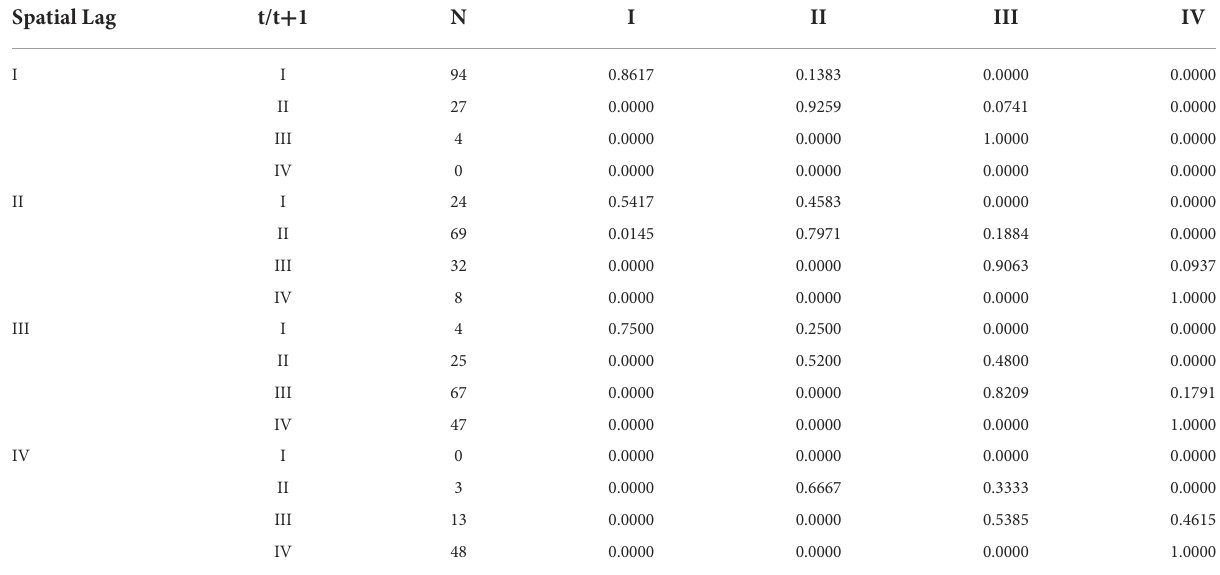
TABLE 6 Markov probability transfer matrix of the MHSS level in China from 2005 to 2020. Spatial Lag t/t + 1 N